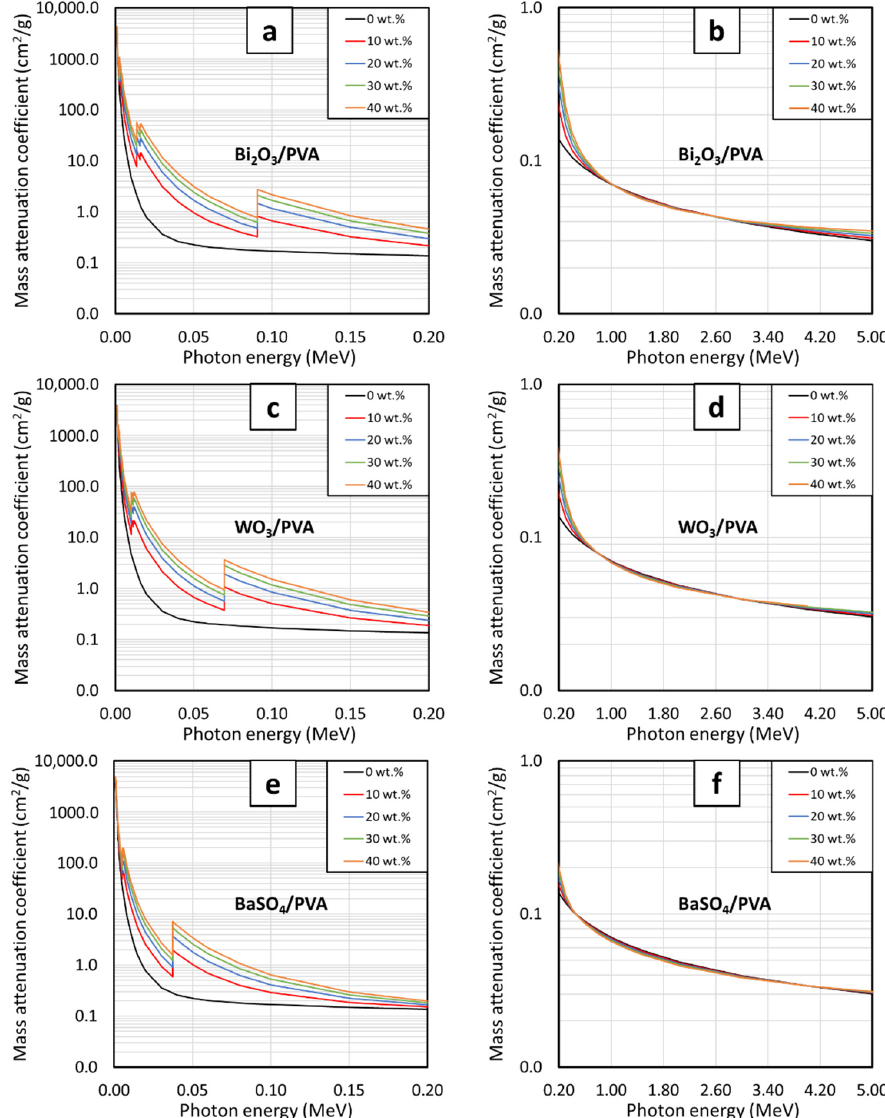
Figure 1. The µ m values of ( a , b ) Bi 2 O 3 /PVA, ( c , d ) WO 3 /PVA, and ( e , f ) BaSO 4 /PVA hydrogels containing varying filler contents of 0, 10, 20, 30, and 40 wt.%, determined at photon energies of ( a , c , e ) 0.001–0.2 MeV and ( b , d , f ) 0.2–5 MeV using XCOM.